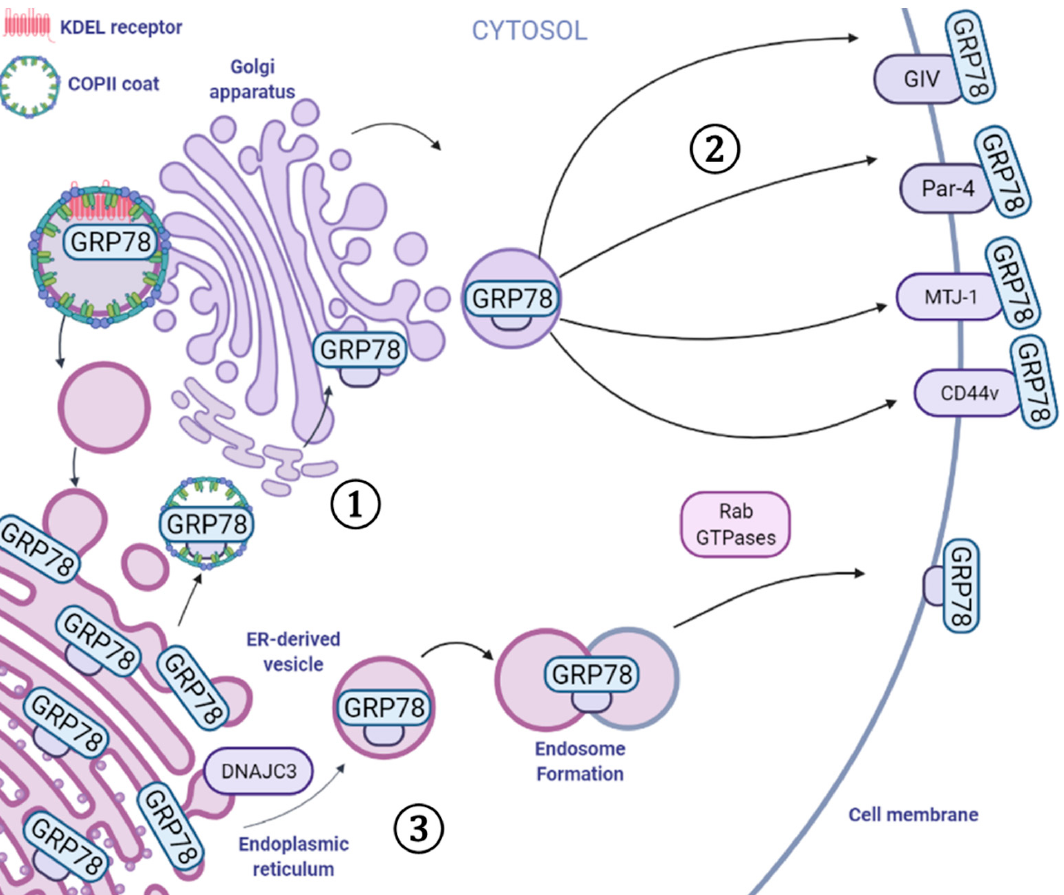
Figure 2. Mediators that facilitate the cell surface localization of GRP78. Under normal physiological conditions, GRP78 is retained in the ER through interactions with the KDEL sequence and the KDEL receptor. ① Under conditions of ER stress, GRP78 can escape ER retention and pass through the Golgi apparatus. ② Moreover, several proteins, including GIV, Par-4, MTJ-1, and CD44v, interact with GRP78 in the ER, which facilitates GRP78 translocation to the cell surface. ③ Alternatively, GRP78 can escape the ER with the assistance of DNAJC3 within an ER-derived vesicle and undergo endosome formation and fusion mediated by several Rab GTPases. Image generated with BioRender.